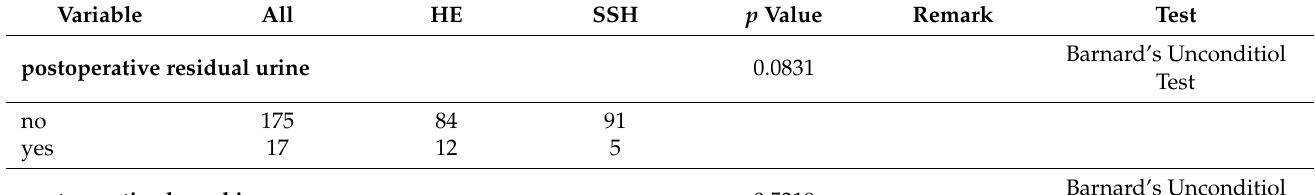
Table 3. Postoperative complications and issues.